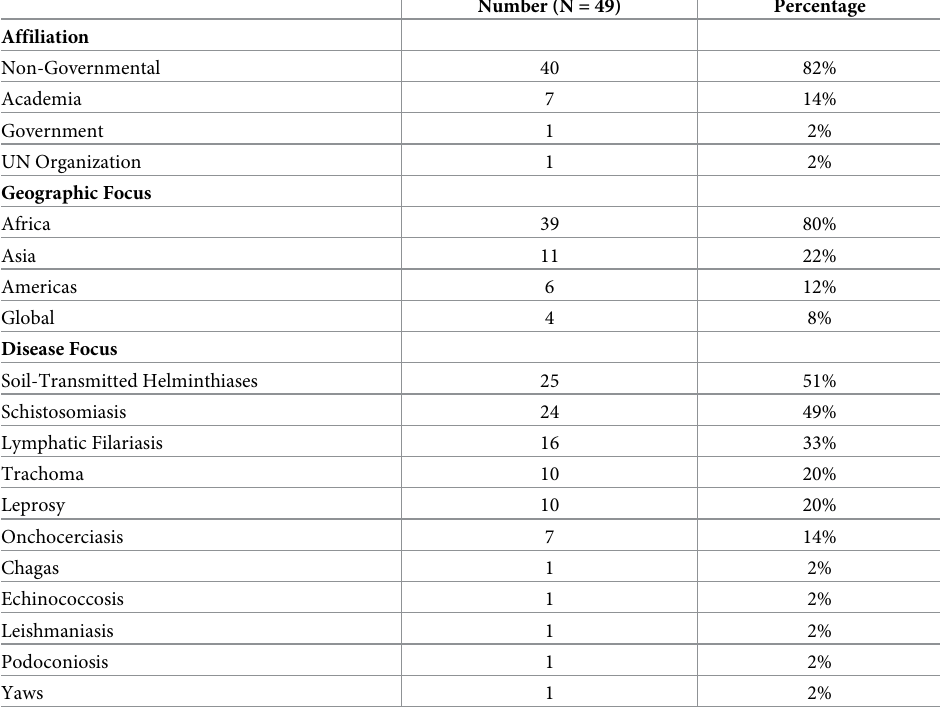
Table 1. Respondent